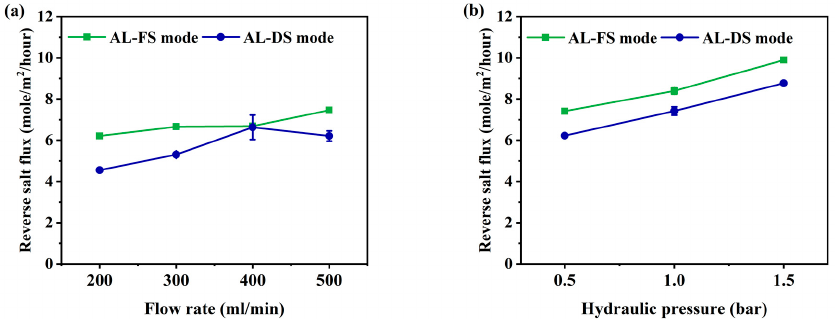
Figure 4. Comparison of the reverse salt flux under AL-FS and AL-DS mode. ( a ) FO process (flow rate: 200–500 mL/min); ( b ) PAFO process (0.5–1.5 bar), and experimental flow rate condition is fixed 500 mL/min; Operating time: 1 h; System temperature: 36.5 ± 0.5 °C.